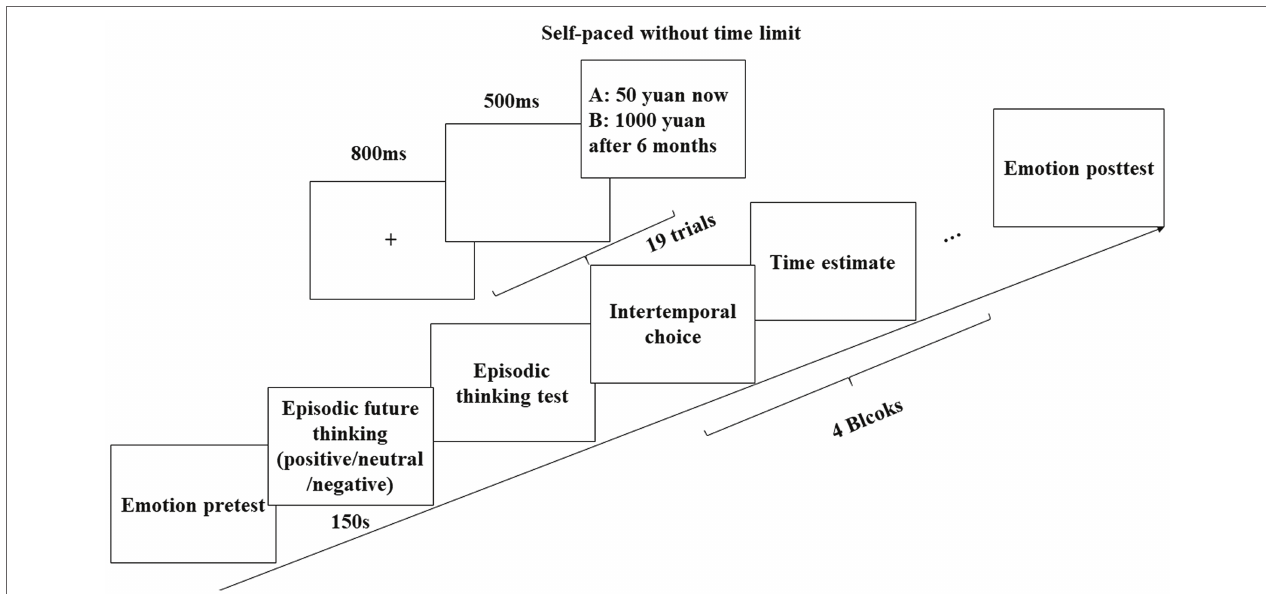
FIGURE 1 | A flow diagram showing the procedures of the experiment.